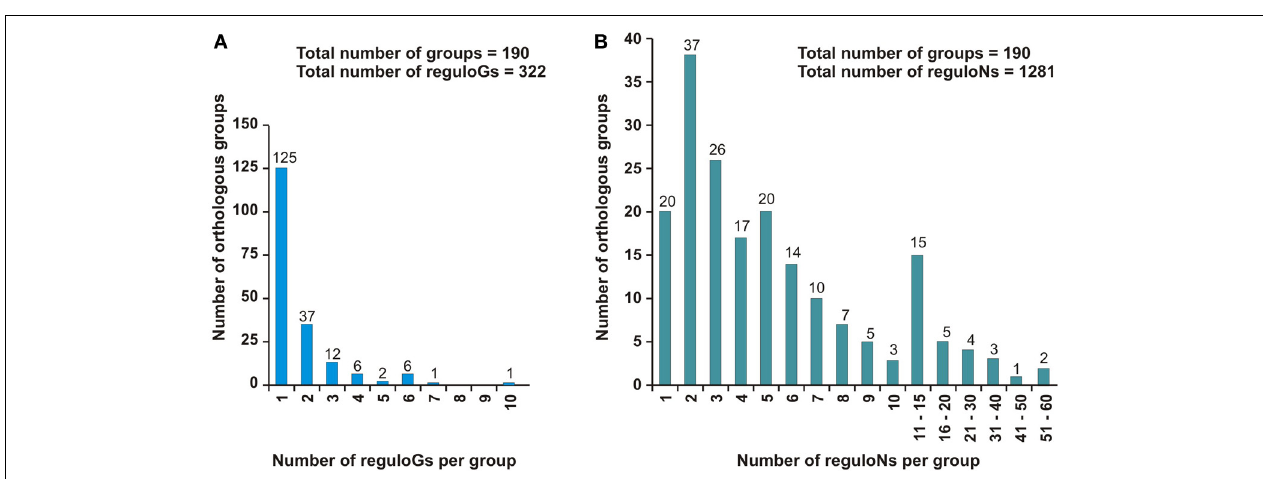
FIGURE 2 | Regulon and regulog content of the studied LacI-TF orthologous groups. (A) Regulog content. (B) Regulon content.